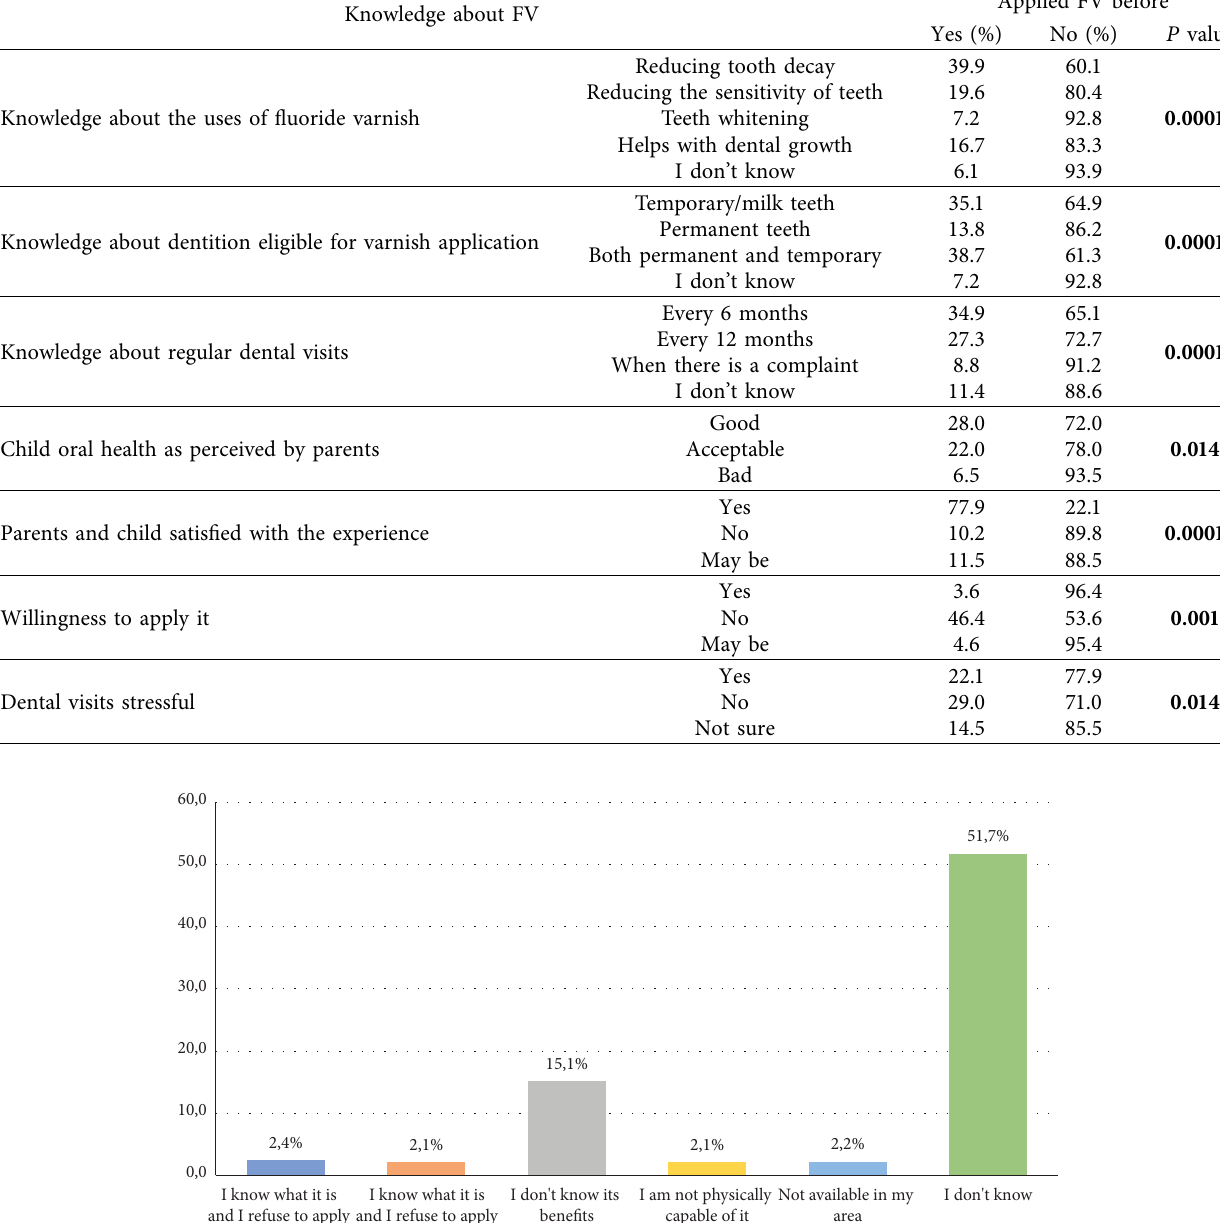
Applied FV before